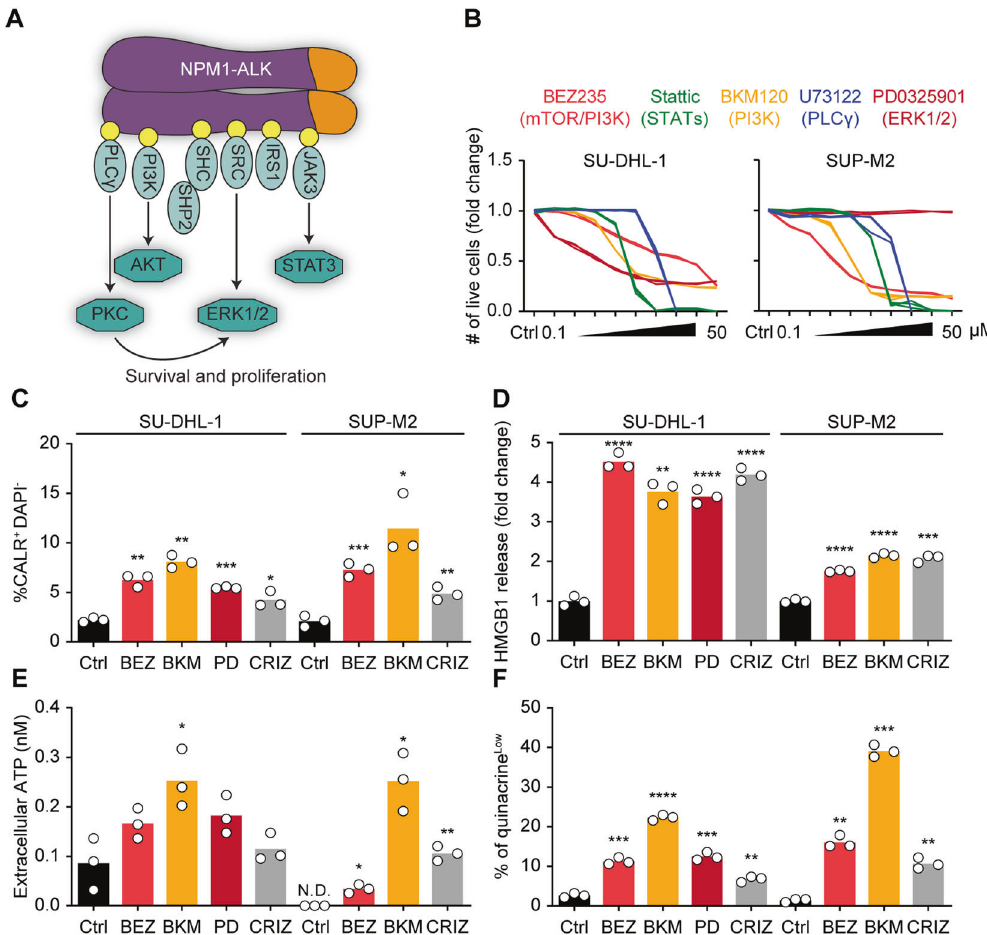
Fig. 3 Dissection of ALK downstream pathways inducing immunogenic cell death. Scheme of ALK downstream signaling pathways ( A ). Human NPM1-ALK + SU-DHL-1 and SUP-M2 cells were treated with PI3K, PI3K/mTOR, ERK1/2, PLC ɣ , and STATs inhibitors (BEZ235, BKM120, PD0325901, U73122, and stattic, respectively) at 0.1, 0.2, 0.5, 1, 2, 5, 10, 20, and 50 μ M. Cell death was evaluated using DiOC 6 (3) and DAPI after 24 h. The number of live cells (DiOC 6 (3) + DAPI - ), normalized to vehicle control, is shown for each replicate ( n = 3) ( B ). NPM1-ALK + SU-DHL-1 and SUP-M2 cells were treated with 2 or 5 μ M of BEZ235 (BEZ); 2 μ M of BKM120 (BKM); 1 or 2 μ M of PD0325901 (PD); 0.1 or 0.5 μ M of crizotinib (CRIZ). After 16 – 18 h (SU-DHL-1) or 24 h (SUP-M2) CALR was indirectly stained on the plasma membrane and percentage of CALR + DAPI - cells was quanti fi ed by fl ow cytometry ( C ). ATP ( E ) and HMGB1 ( D ) were quanti fi ed in the extracellular milieu of cells treated for 16 – 18 h ( E ) or 24 h ( D ), using a luciferase-dependent assay or an ELISA, respectively. The propensity of quinacrine to accumulate in ATP-rich vesicles was exploited to quantify the intracellular content of ATP by fl ow cytometry after 16 – 18 h of treatment. DAPI was employed as exclusion dye for permeabilized cells. Percentages of quinacrine low cells within DAPI - population are displayed in F . Individual replicates are shown ( n = 3) from one out of three independent experiments. Statistical signi fi cance was calculated using the Student ’ s t test. * p < 0.05, ** p < 0.01, *** p < 0.001, **** p < 0.0001 vs . vehicle-treated cells ( B – F ). N.D.